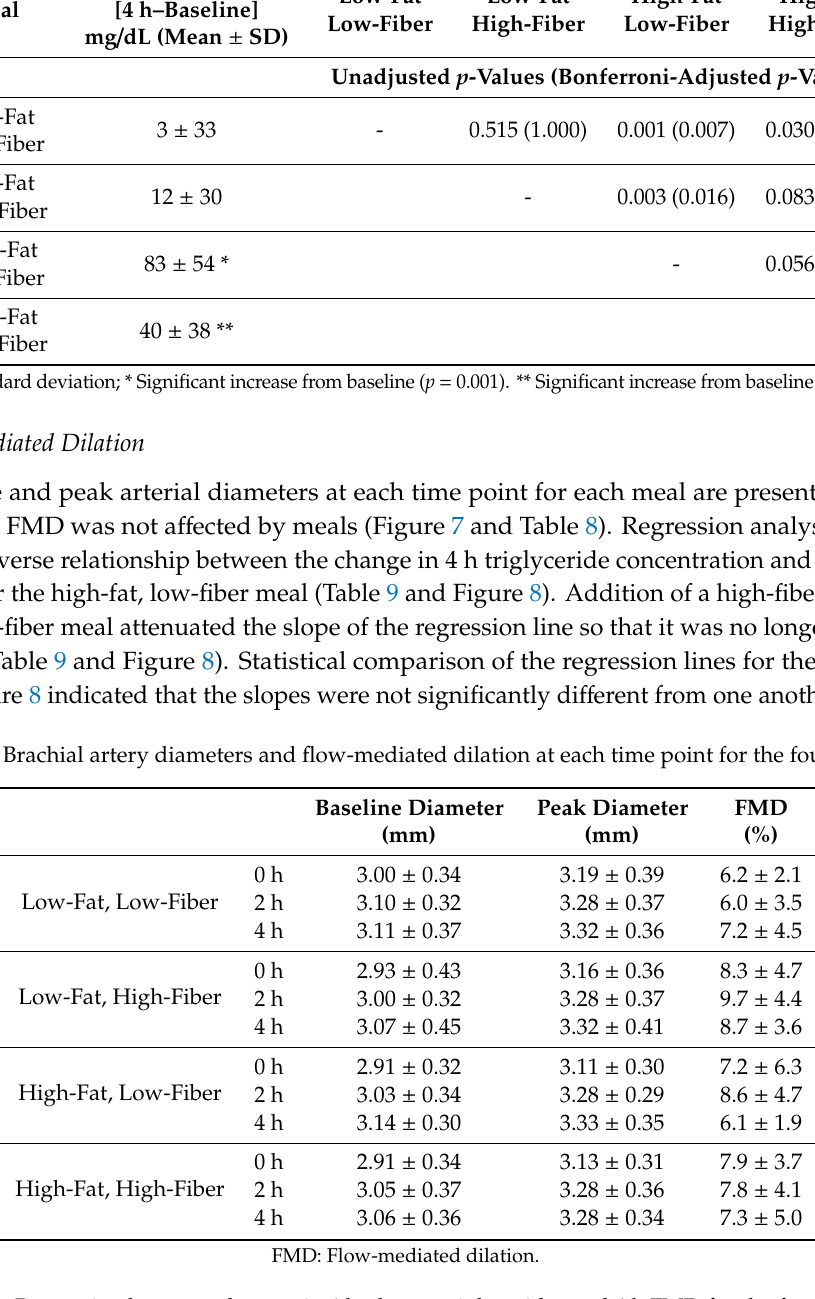
Table 9. Regression between changes in 4 h plasma triglycerides and 4 h FMD for the four meals.